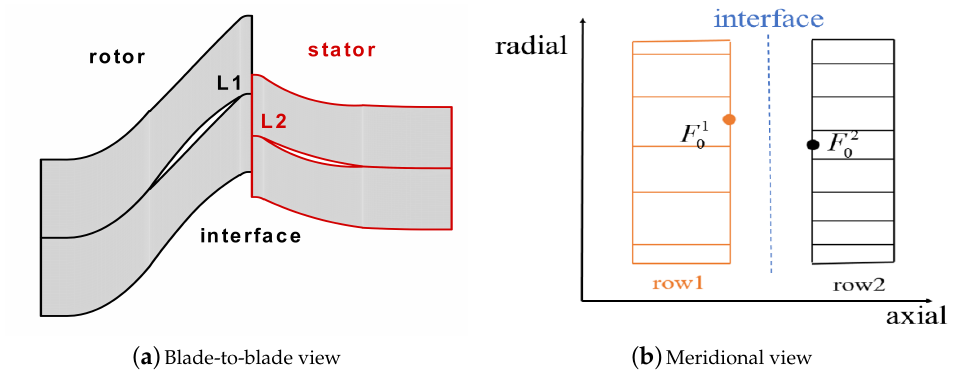
Figure 8. The blade-to-blade and meridional views of an